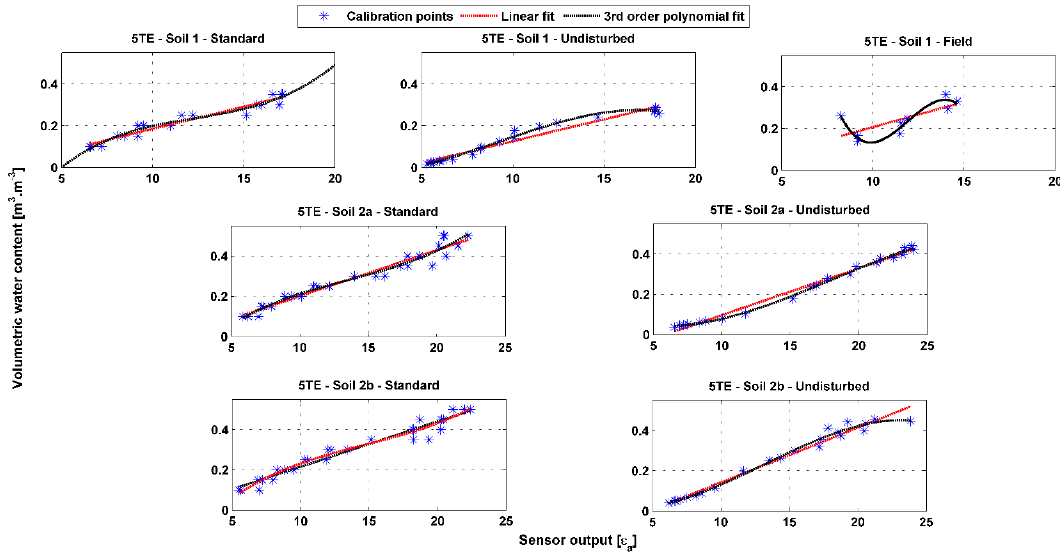
Figure A2. Linear and third-order polynomial fitting curves to 5TE sensor calibration data obtained by means of standard, undisturbed and field methods on soil 1, 2a and 2b.